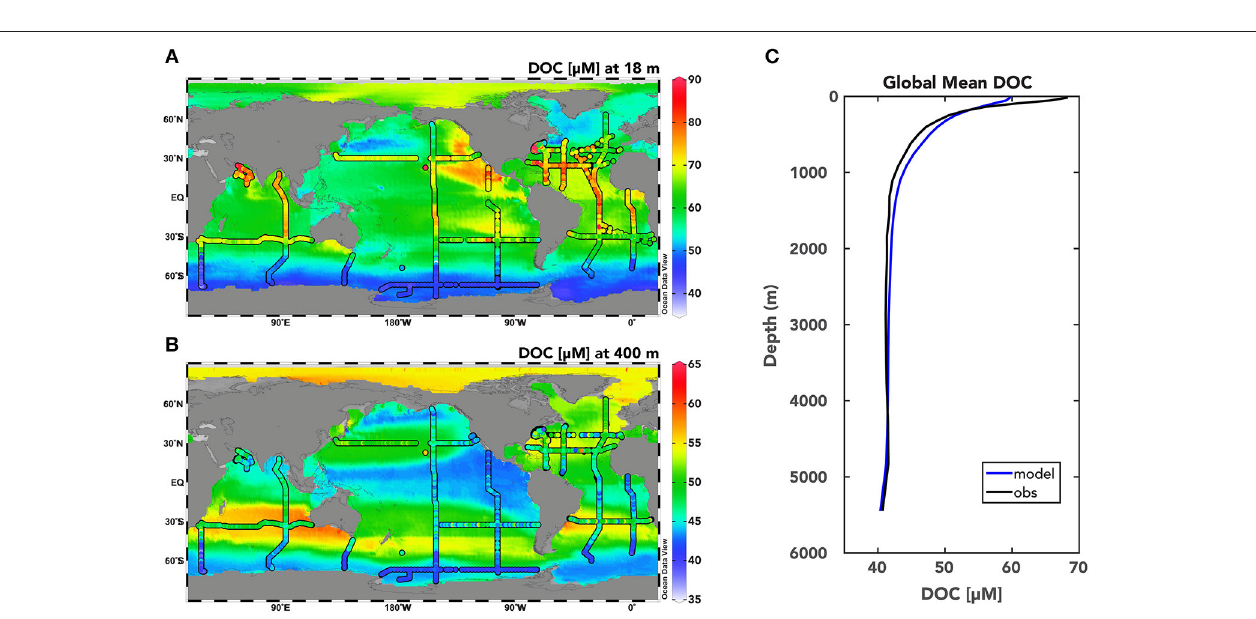
FIGURE 3 | Modeled DOC distributions from the global ocean DOC cycling inverse model with Model II DOC cycling. Model simulated total DOC concentrations [ µ M] (DOC SL + DOC SR + DOC R ) are plotted for the euphotic zone at 18m (A) and within the mesopelagic zone at 400m (B) from the solution to the Model II DOC cycling case with Redfield r CP of DOM production. Observations of total DOC from the global database at each depth are shown with the colored dots. (C) Global mean simulated (blue) and observed (black) depth profile of DOC concentrations [ µ M].